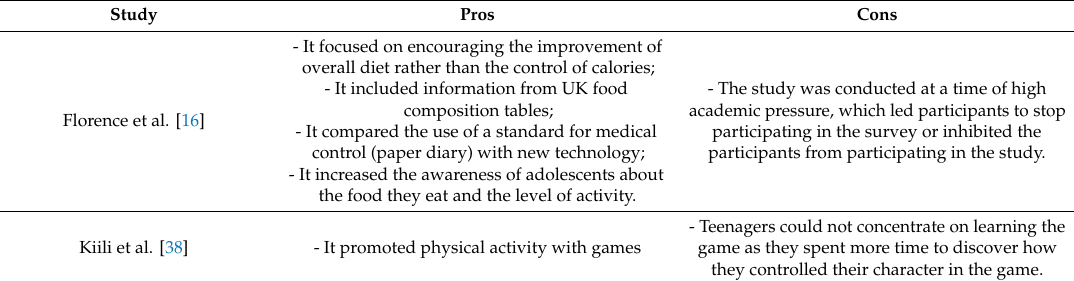
Table 4. Analysis of the pros and cons of the different studies.